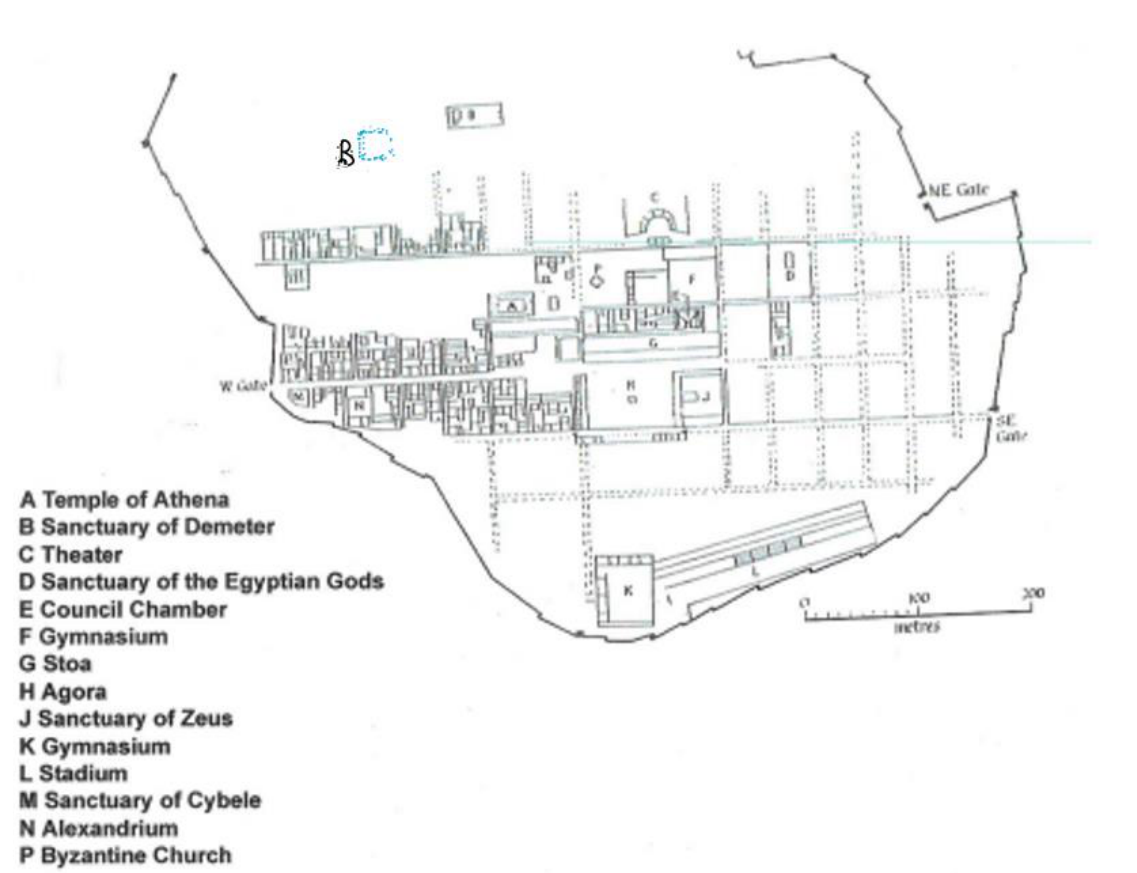
Figure 13. Detailed map of walled urban Priene and inner city main structures. Figure from [1], p. 338.